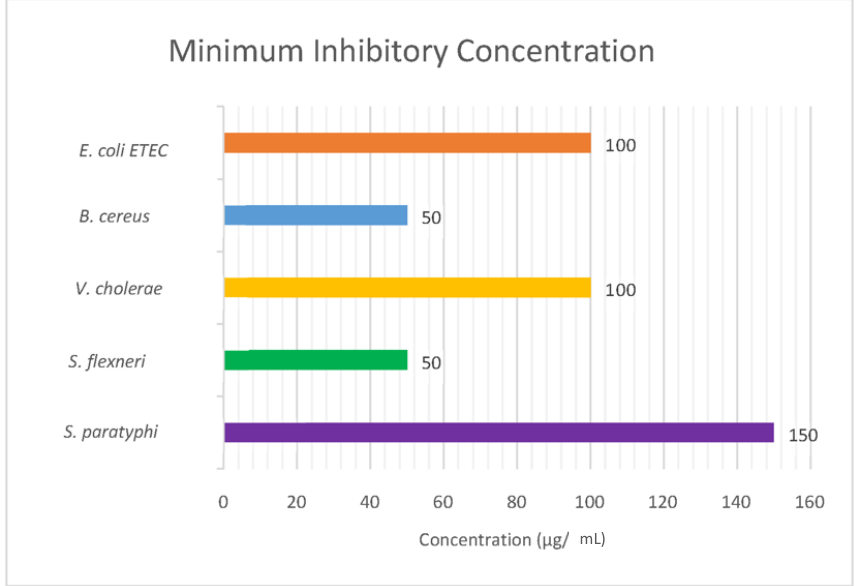
Figure 8. Results of the minimum inhibitory test. S. paratyphi required the highest concentration of AgNPs at 150 µg/mL, while the lowest amount, 50 µg/mL, was required by B. cereus and S. flexneri . E. coli (ETEC) and V. Cholerae required the same concentration of AgNPs at 100 µg/mL.